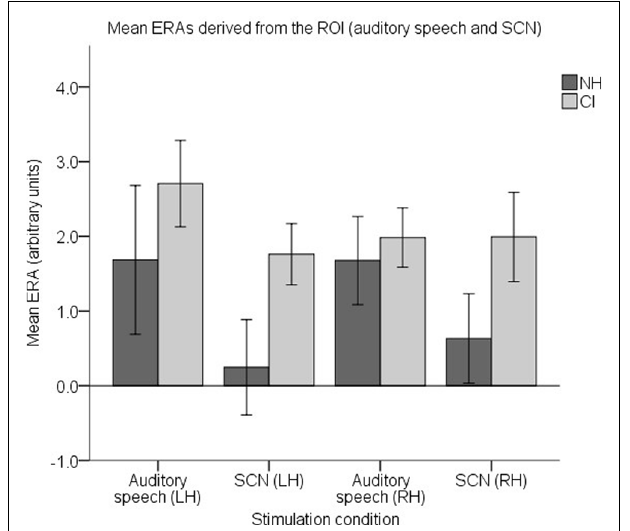
FIGURE 12 | Mean ERAs ( N = 39) derived from the ROI for the SCN and SSSN conditions. Mean ERAs are shown for each group corresponding